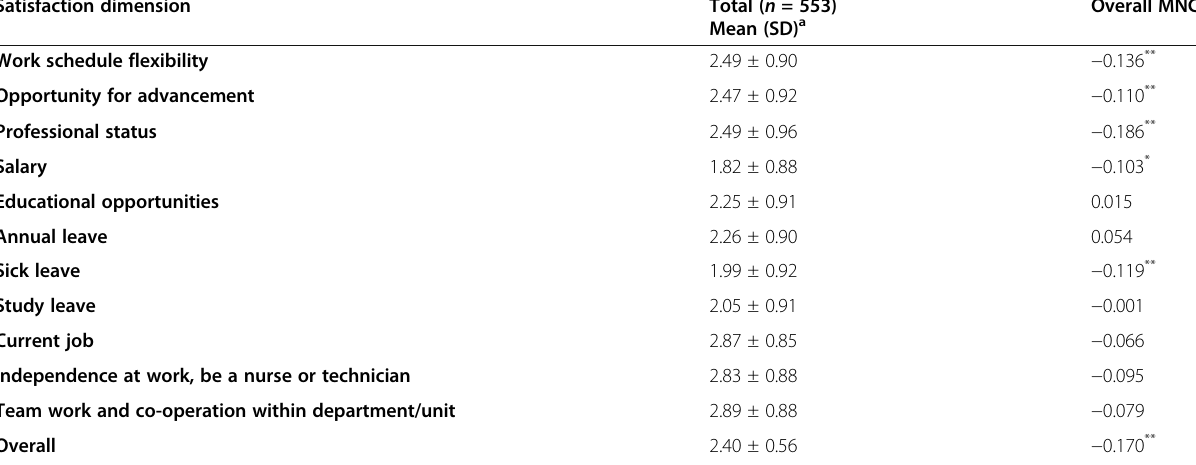
Table 5 Spearman rank-order correlations between missed nursing care and satisfaction Satisfaction